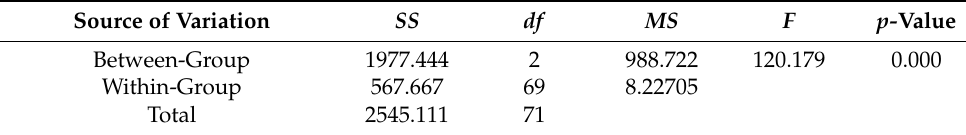
Table 4. One-way ANOVA (analysis of variance) for the effects of VSIDCS, MoCA, and MMSE on